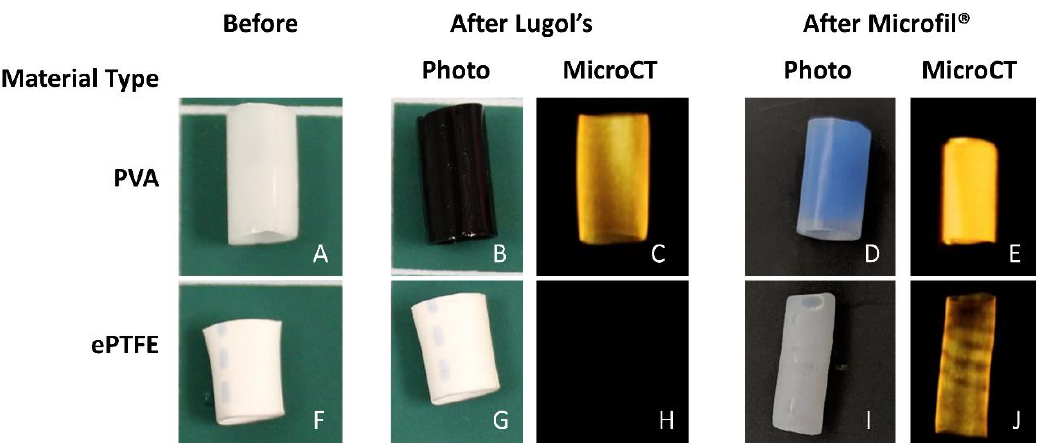
Figure 4. Results of material processing and microcomputed tomography (microCT) images for materials (poly(vinyl alcohol) (PVA) = ( A–E ), ePTFE = ( F–J )) not exposed to blood. Samples were materials (poly(vinyl alcohol) (PVA) = ( A – E ), ePTFE = ( F – J )) not exposed to blood. Samples were exposed to Lugol’s overnight ( B,C,G,H ), which was taken up by the PVA ( B ) and rendered the PVA exposed to Lugol’s overnight ( B , C , G , H ), which was taken up by the PVA ( B ) and rendered the PVA radiopaque ( C ), but did not alter the ePTFE ( G , H ). Lumens of each material were filled with Microfil radiopaque ( C ), but did not alter the ePTFE ( G,H ). Lumens of each material were filled with Microfil ® ( D,E,I,J ). Microfil ® stayed in the lumen of the PVA ( D,E ), but permeated the ePTFE ( I ), causing it to leak and making the walls of the material radiopaque ( J ).